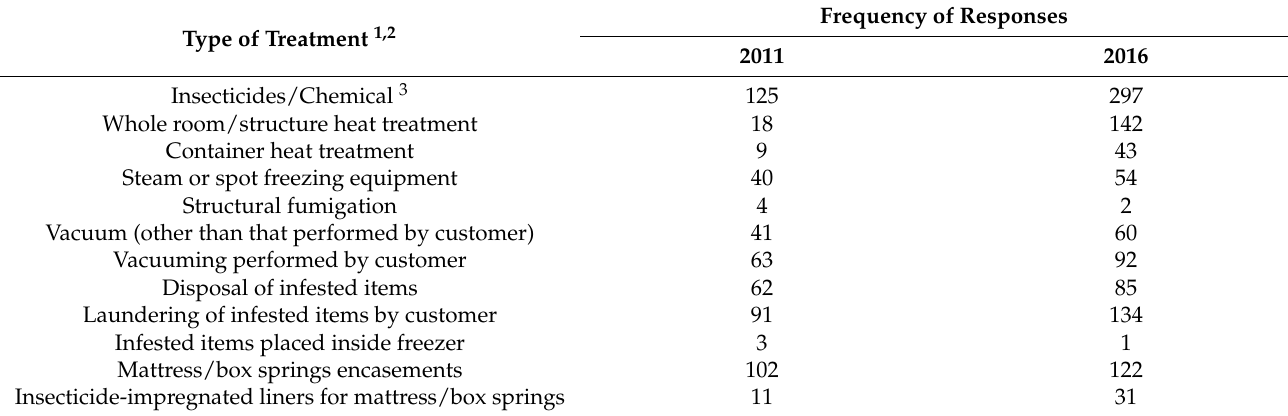
Table 2. Types of treatments used by Ohio’s licensed PMPs for bed bug management in 2011 and 2016. Type of Treatment